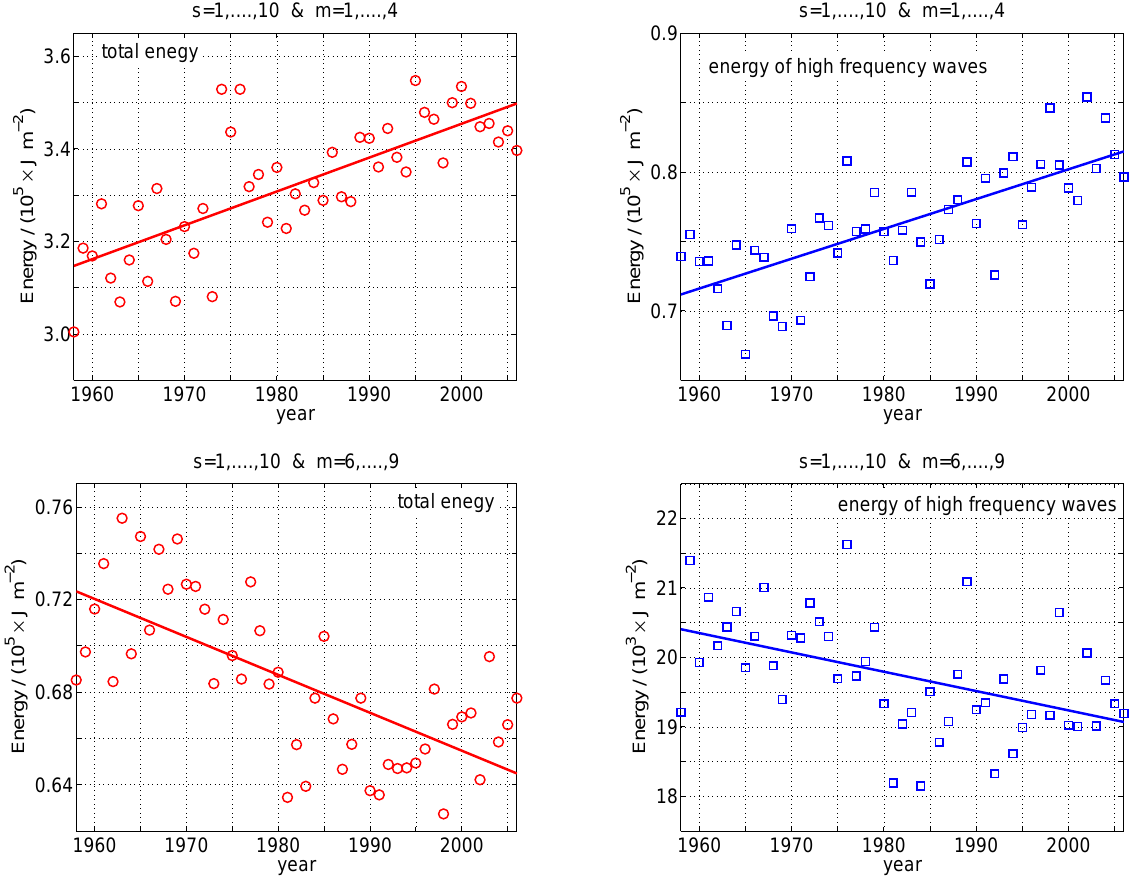
Fig. 4. November–April mean energy associated with baroclinic Rossby waves of wave numbers s = 1 ,..., 10: (upper row) sum of the energy of the deeper baroclinic modes ( m = 1 ,..., 4), and (lower row) sum of the energy of the shallower baroclinic modes m = 6 ,..., 9.